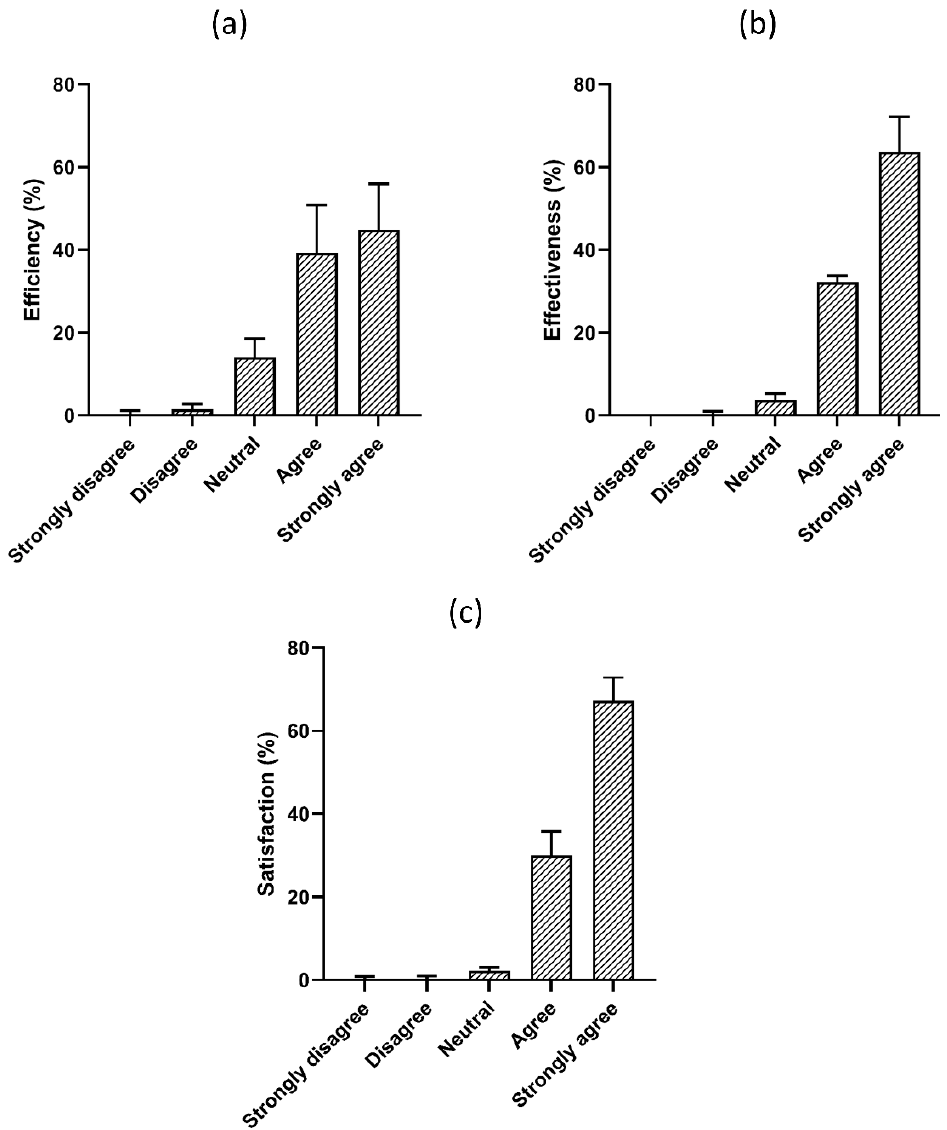
Figure 5. The graphical presentation of Table 5 shows ( a ) high values for strongly agreeing towards efficiency for the “Gamified Music Steps”, ( b ) high values for strongly agreeing towards effectiveness for the “Gamified Music Steps”, ( c ) showing high values for strongly agreeing towards satisfaction for the “Gamified Music Steps”.